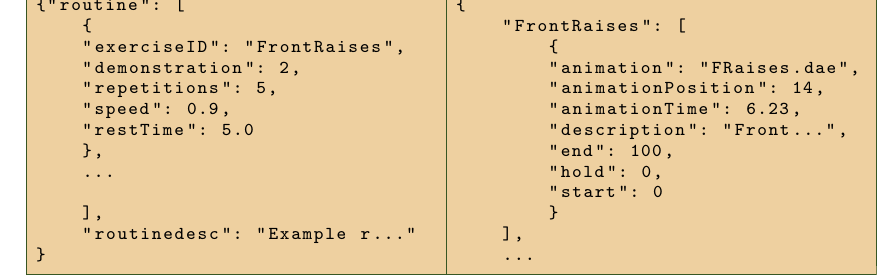
Fig. 2 Left A routine as stored in JSON. Note the use of exercises names defined in the exercise dictionary. Right An entry of the exercise dictionary as stored in